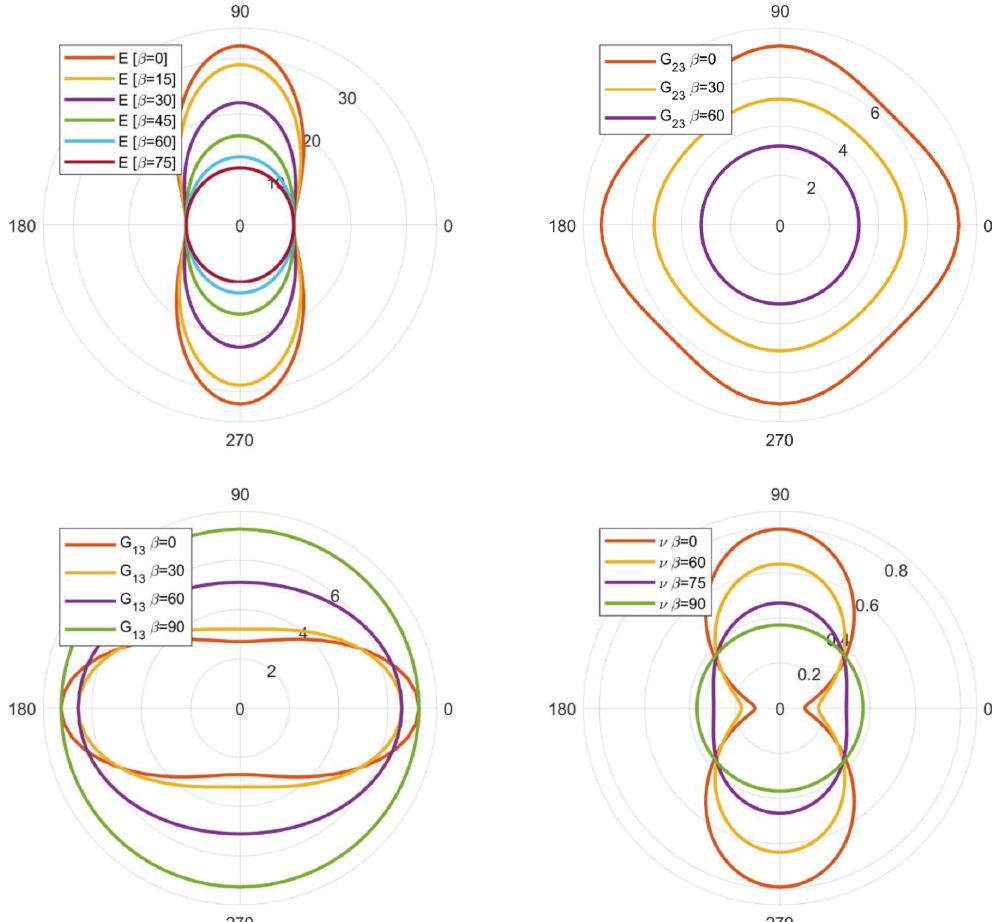
Figure A6. Benchmarks to Li (1976, their Fig. 3) for hexagonal thallium.